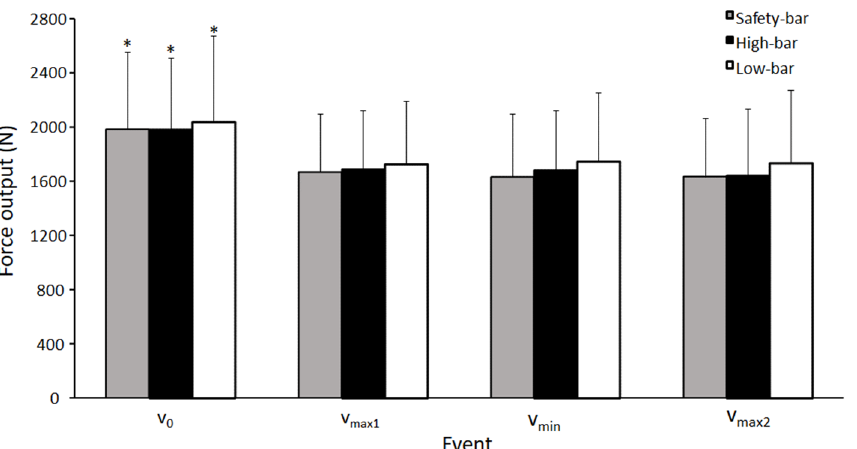
Figure 9. Mean ( ± SD) force output at the events v 0, v max1 , v min , and v max2 for the high-bar, low-bar, and safety-bar squat during 3-RM. * indicates a significant difference between this event and all other events for all squat conditions on a p ≤ 0.05 level.